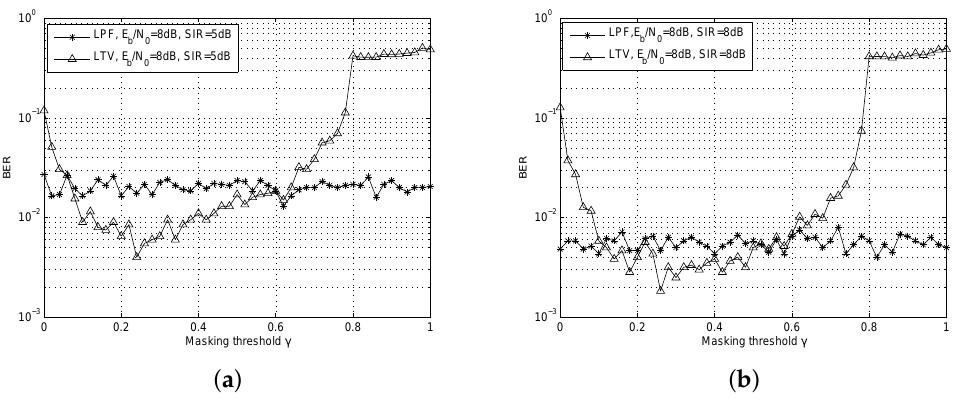
Figure 11. BER varies with different masking thresholds. ( a ) E b / N 0 = 8 dB, SIR = 5 dB; ( b ) E b / N 0 = 8 dB, SIR = 8